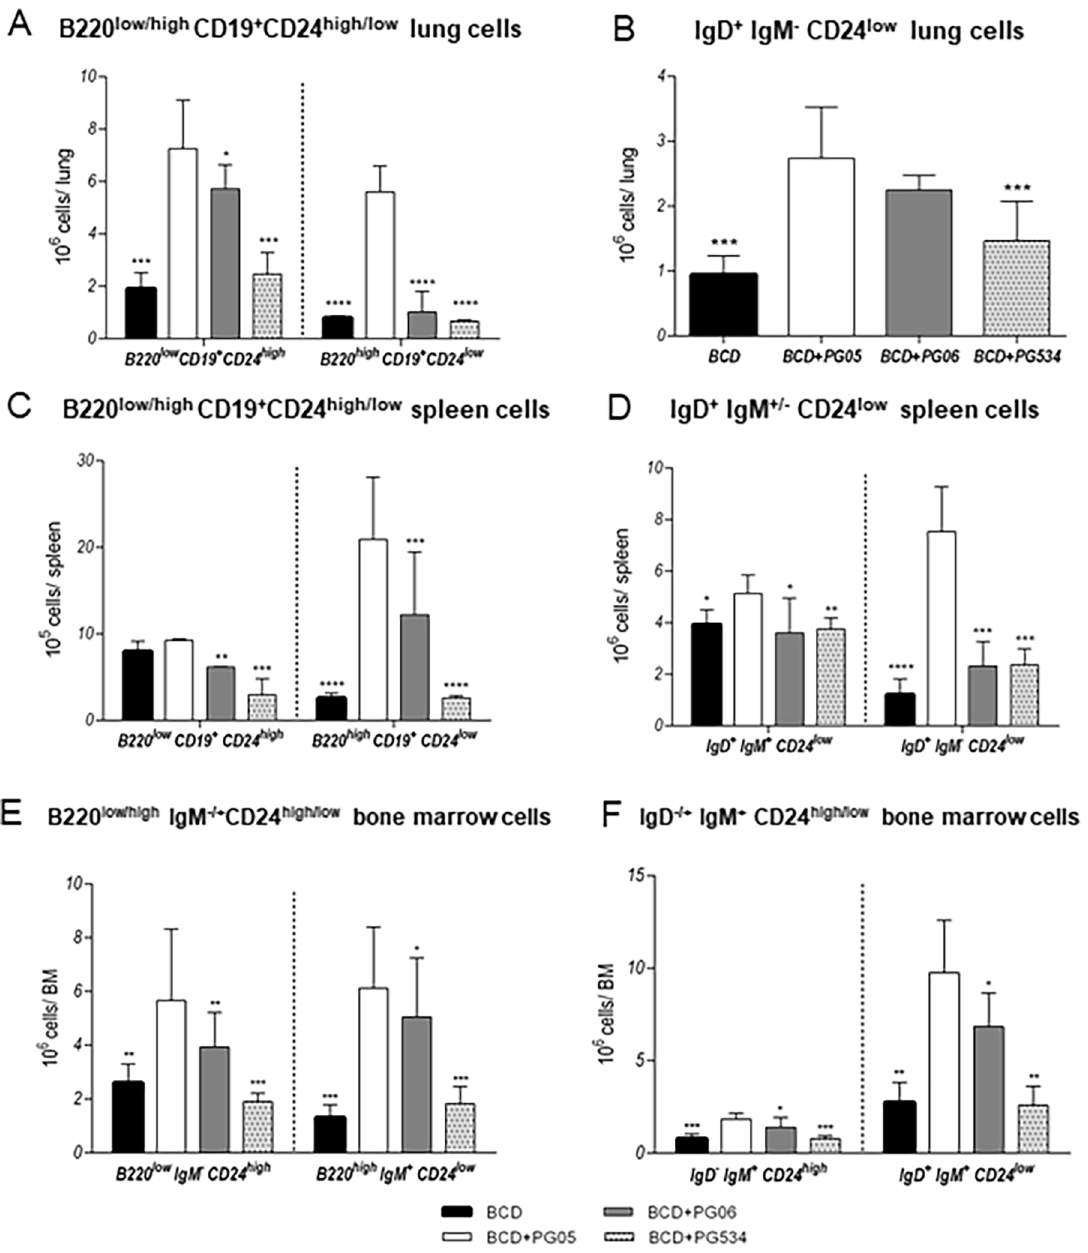
Fig 7. Effect of lactobacilli peptidoglycans on lung, spleen and bone marrow (BM) B cells numbers after Streptococcuspneumoniae infection in malnourished mice. Immunocompromised-malnourished mice were replete for 7 days with a balanced conventional diet (BCD) or BCD supplemented with peptidoglycans from Lactobacillusrhamnosus CRL1505(BCD+PG05), L . plantarum CRL1506 (BCD+PG06) or L . rhamnosus CRL534 (BCD+PG534), and then challengedwith S . pneumoniae . The numbersof B cells were studied fifteendays after the pneumococcal challenge. Differentlung B cells subpopulations: (A) B220 low CD19 + CD24 high (immature cells) and B220 high CD19 + CD24 low (mature cells) (B) IgD + IgM - CD24 low (mature cells) Differentspleen B cells subpopulations: (C) B220 low CD19 + CD24 high (immature cells) and B220 high CD19 + CD24 low (mature cells). (D) IgD + IgM + CD24 low (immature cells) and IgD + IgM - CD24 low (mature cells). Different B cells subpopulations in BM: (E) B220 low IgM - CD24 high pre-pro B cells and B220 high IgM + CD24 low matureB cells. (F) IgD - IgM + CD24 high immature B cells and IgD + IgM + CD24 low matureB cells. Results represent data from threeindependent experiments. Results are expressedas mean ± SD. Asterisksrepresent statisticaldifferences comparedwith BCD+PG05group. (cid:3) p < 0.05, (cid:3)(cid:3) p < 0.005, (cid:3)(cid:3)(cid:3) / (cid:3)(cid:3)(cid:3)(cid:3) p (cid:20) 0.001.